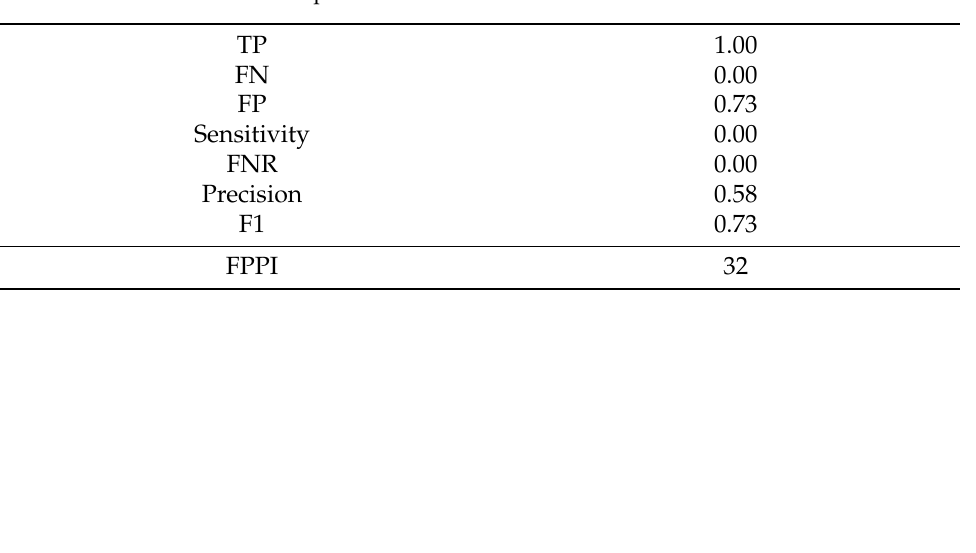
Table 3. Results of the detection